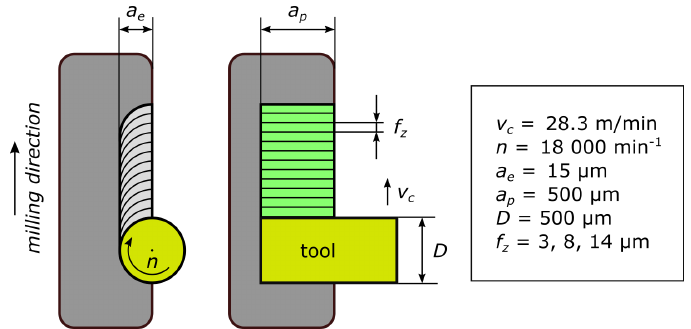
Figure 2. Schematics of the machined structures with corresponding process